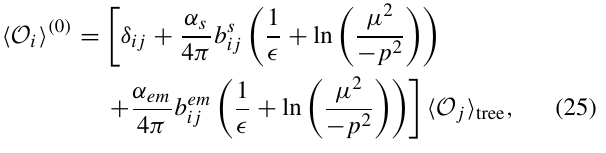
( q ) AB (cid:2) (cid:2) = τ e ) associated to the Wilson coefficient C ( q ) AB 1 2 (cid:2) 1 (cid:2) 2 (